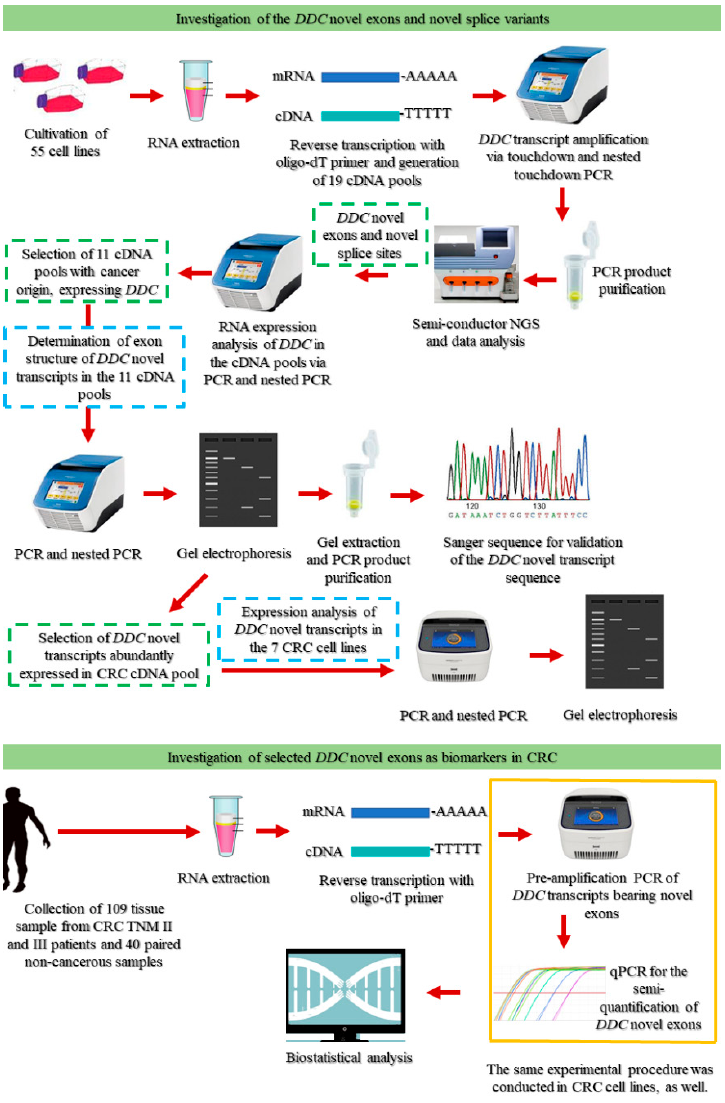
Figure 7. Overview of the experimental workflow.